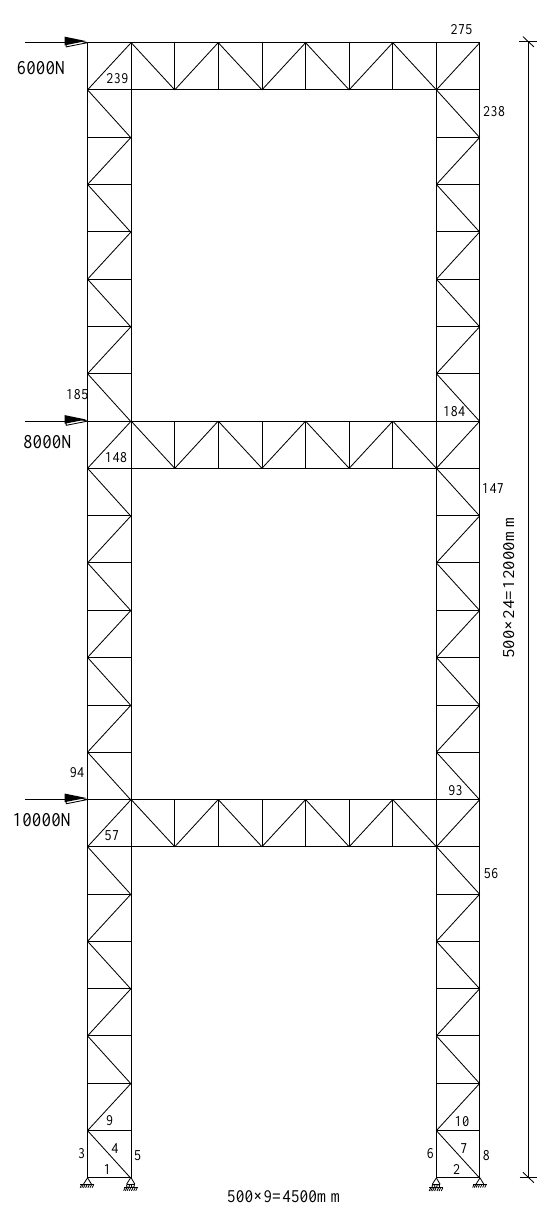
Figure 2. An initial structure of a 275-bar truss. Material parameters: Elastic modulus is 200 GPa, density is 7800 kg/m 3 , L = 0.5 m, and initial cross-sectional area of each bar is 314 mm 2 .